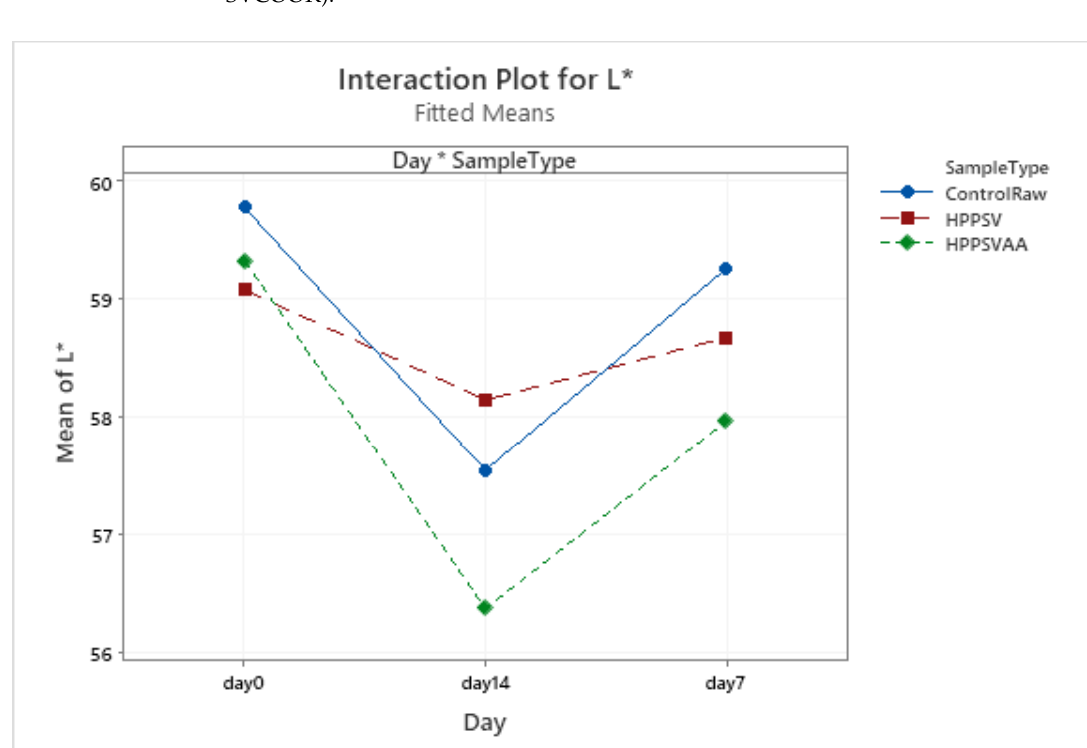
Figure A16 . Effect of treatments and storage time on the L* coordinate of plant-based patty (HPPSV: HPP-SVCOOK).